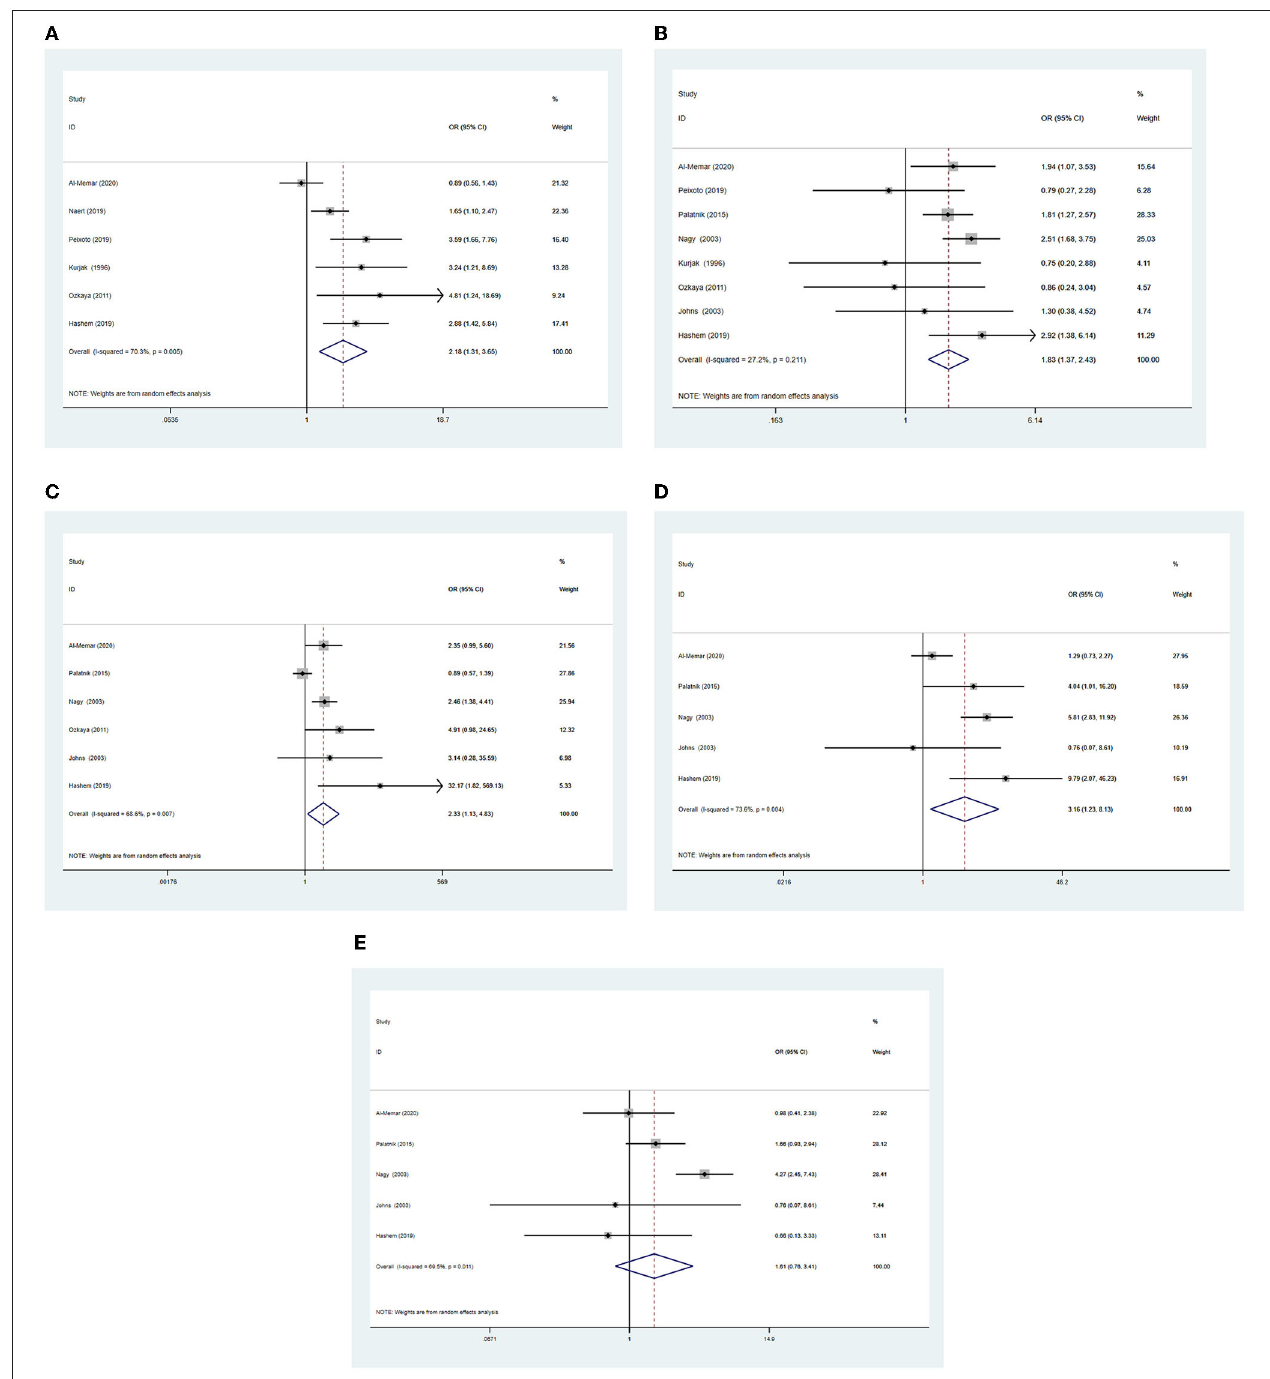
FIGURE 2 | Forest plots of outcomes comparing the intrauterine hematoma group with the control group (A) , spontaneous abortion (B) , preterm birth (C) , fetal growth restriction (D) , placenta abruption (E) , pre-eclampsia.